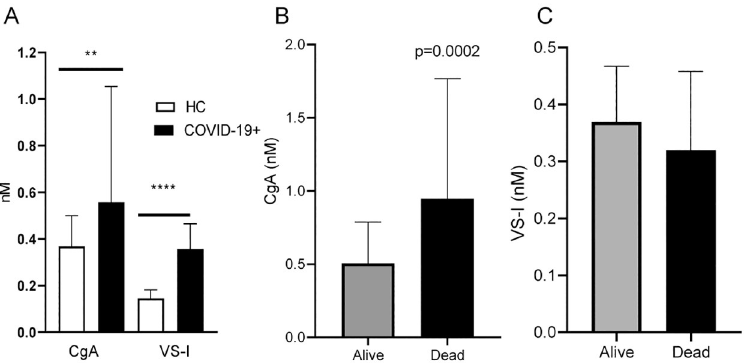
Fig 1. Panel A: CgA and VS-I plasma levels in age- and sex-matched healthy controls (HC) and COVID-19 patients at hospital admission. Panel B: CgA plasma levels in COVID-19 patients with favorable outcome (Alive) or who died (Dead). Panel C: VS-I in Alive or Dead patients. �� p <